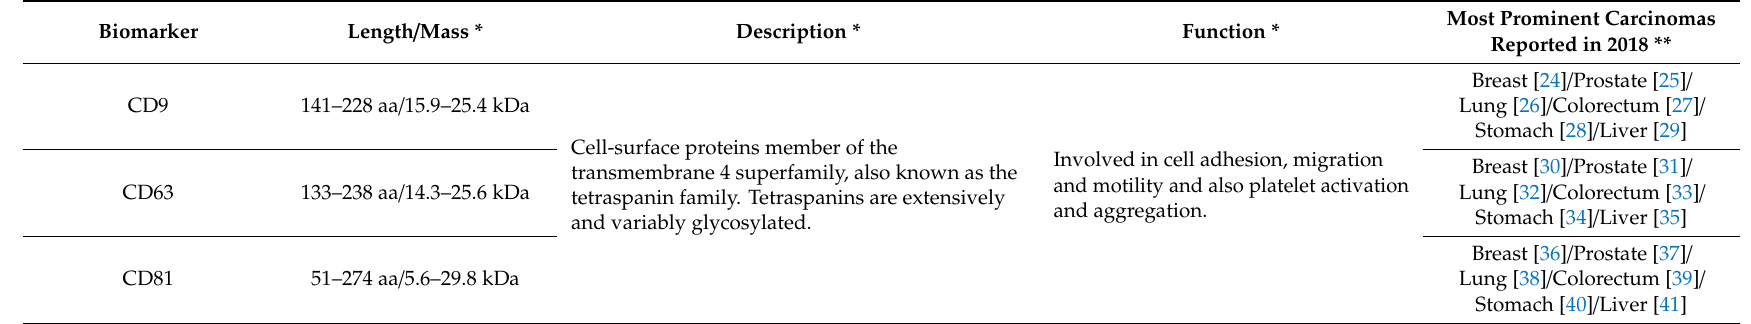
Table 2. Description of the biomarkers selected in this